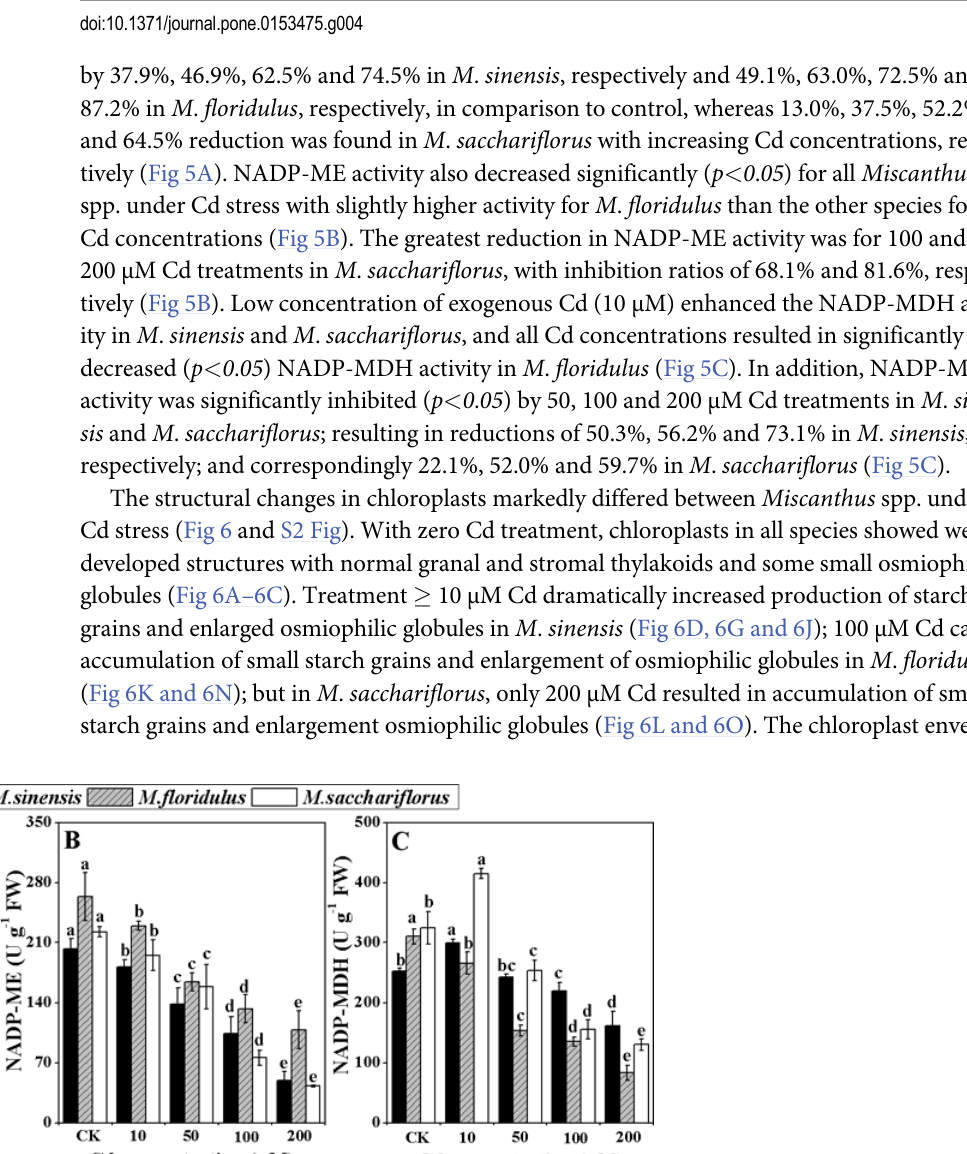
PLOS ONE | DOI:10.1371/journal.pone.0153475 April 12,